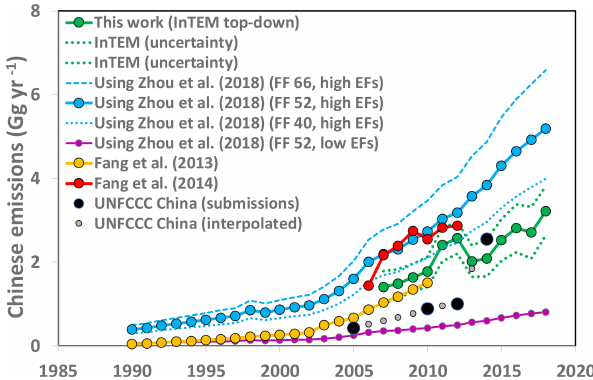
Figure 4. Bottom-up and top-down emission estimates scaled for the whole of